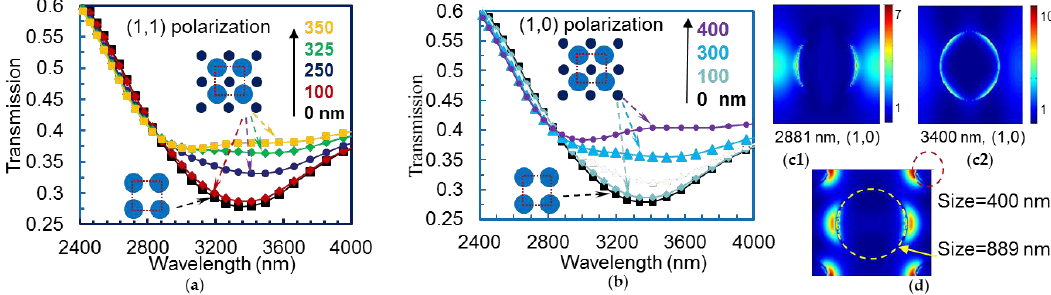
Figure 1. Simulations of transmission spectrum through super-lattice hole array in Al-doped ZnO (AZO) for light polarization in the (1,1) direction ( a ) and in the (1,0) direction ( b ). A smaller hole is introduced in the unit cell of the bigger hole array, as shown in insert indicated by dashed red squares. The colored numbers near the solid black arrow indicate the diameter (in nm) of the smaller holes used for each simulation respectively; ( c ) Computed E-field intensities at two wavelengths of 2881 nm (c1) and 3400 nm (c2) with a polarization in (1,0); ( d ) Computed E-field intensity in the dual hole structure with a polarization in (1,0).